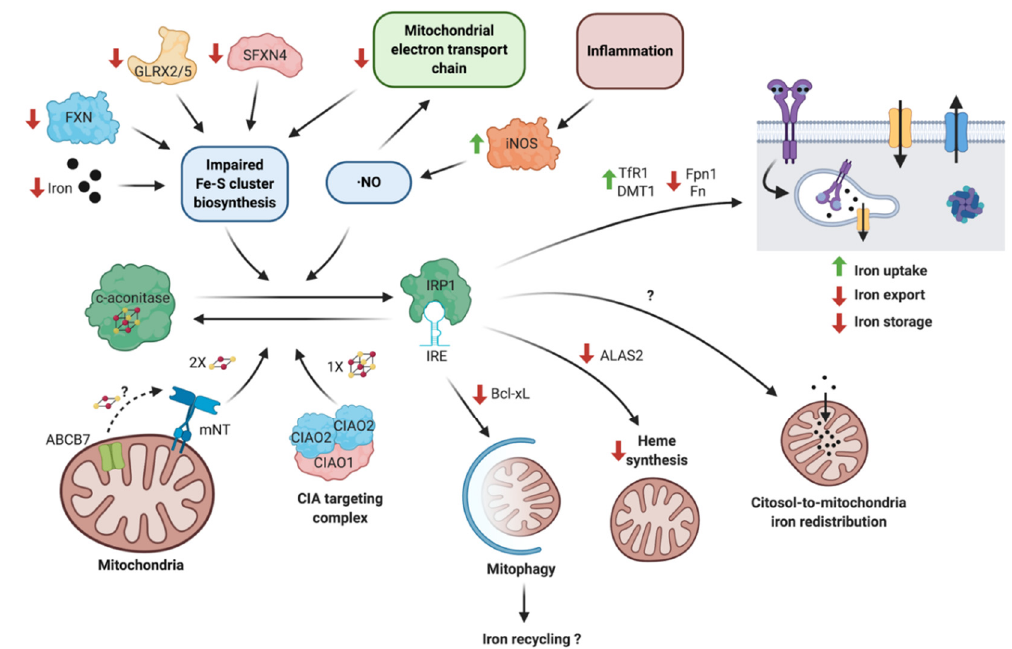
Figure 1. Regulatory mechanisms and functions of iron regulatory protein 1 (IRP1). The bifunctional protein c-aconitase/IRP1 is regulated by several mechanisms. C-aconitase is converted to IRP1 through two main processes: (i) Impaired Fe-S cluster biosynthesis, as a result of decreased mitochondrial iron availability, defects in the Fe-S cluster assembly (ISC) machinery, or bioenergetic failure, or (ii), through downstream inflammation by ·NO-mediated Fe-S cluster disruption. Conversely, IRP1 is turned back into c-aconitase by mNT under oxidative stress or by a specialized branch of the CIA targeting complex. The binding of IRP1 to iron response elements (IRE) in specific mRNA targets regulates mitophagy, heme synthesis, iron redistribution to mitochondria, and iron uptake and storage. FXN: frataxin; GLRX2/5; Glutaredoxin-2/5; SFXN4: Sideroflexin 4; CIA: cytoplasmic iron-sulfur assembly; and mNT: mitoNEET. Created with BioRender.com.